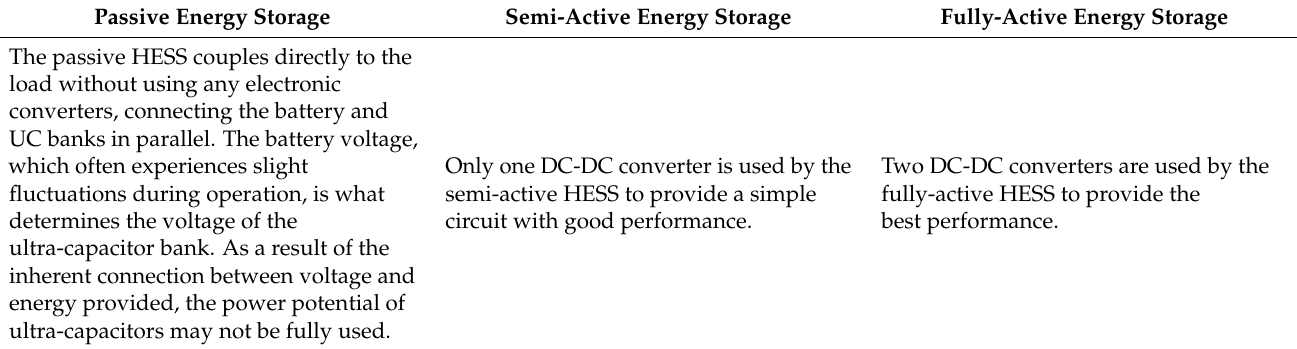
Table 9. Difference between active and passive energy storage